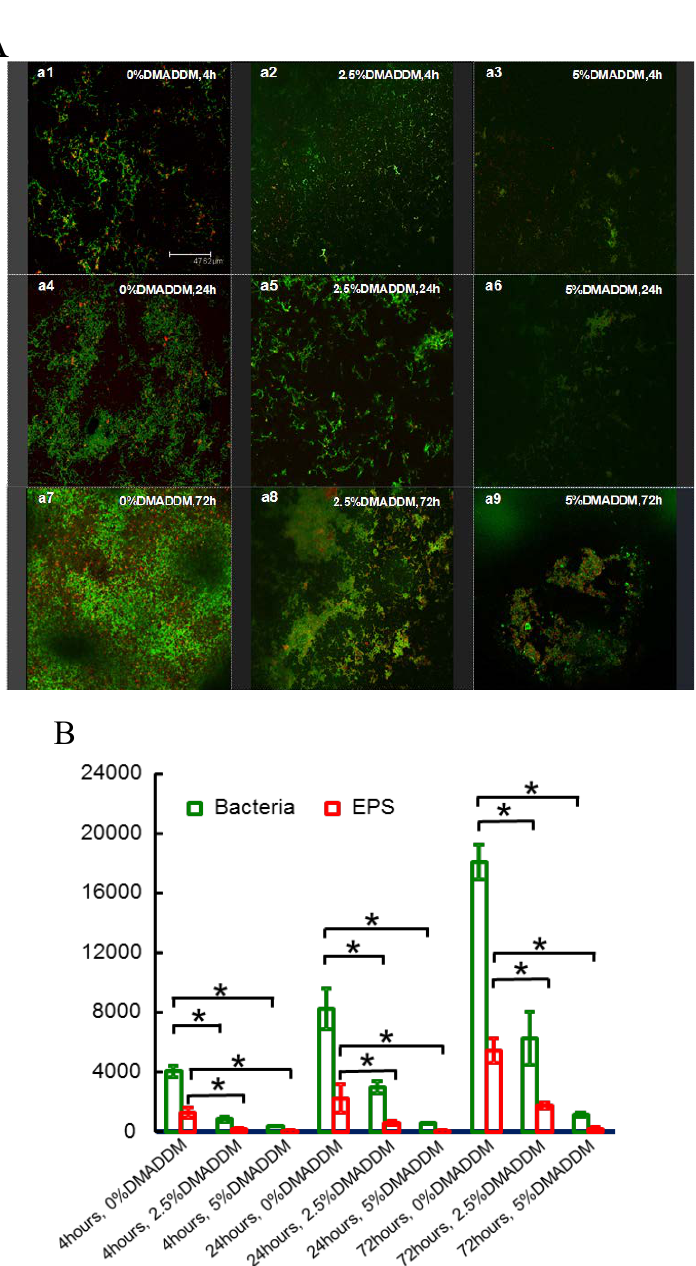
Figure 5. ( A ) EPS staining of biofilms on the cured disks of the three groups at different stages. Bacteria were stained green, and EPS were stained red. Incorporation of DMADDM into the adhesive reduced both the bacteria and EPS; ( B ) Part quantified analysis of EPS production and bacteria. Results were averaged from three randomly selected views of each group and are presented as mean ± standard deviation ( * p <